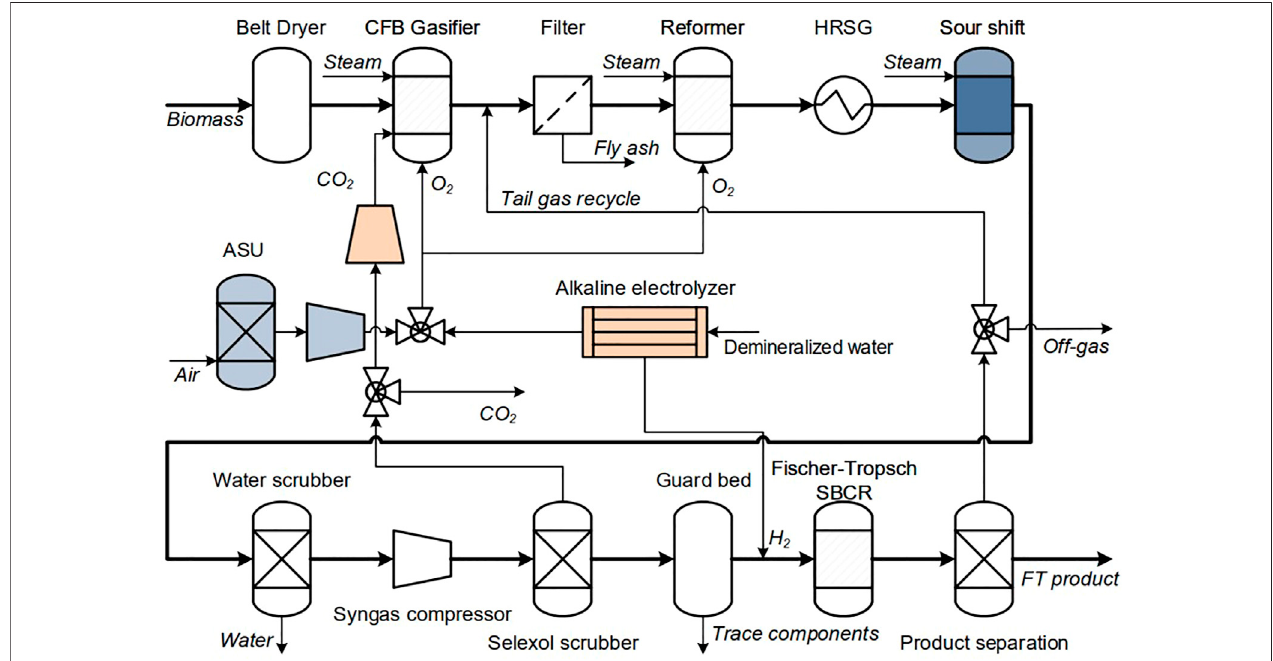
FIGURE 3 | Process fl owsheet – blue signi fi es equipment only operated during BA mode, orange during EA mode.